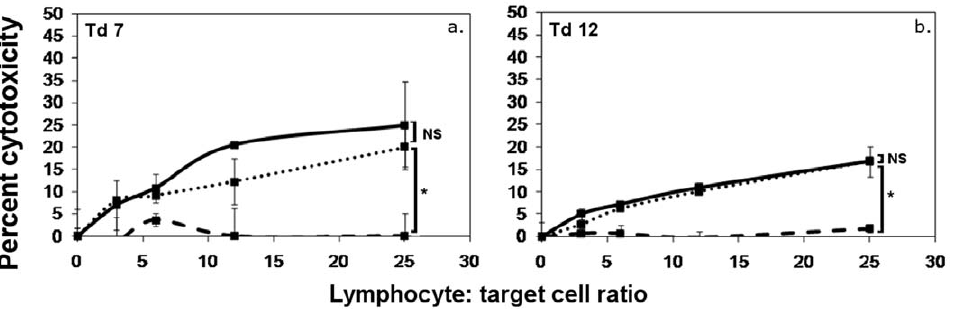
Figure 6. ADCC responses of plastic non adherent cells from naive devils against K562 cells. 51 Cr release assays were performed for 18 hr at lymphocyte: target ratios of 25:1, 12:1, 6:1 and 3:1, in the presence or absence of K562 immune serum. Solid black lines represent the responses of MNC in the presence of immune serum. Dashed lines represent levels of cytotoxicity in naive MNC without serum. Dotted lines represent the responses of plastic non adherent cells in the presence of immune serum. There was no statistically significant difference between the responses of MNC and plastic non adherent cells in the presence of serum. The responses of plastic non adherent cells in the presence of immunised serum were significantly greater than samples without immune serum (F test; * p , 0.05).